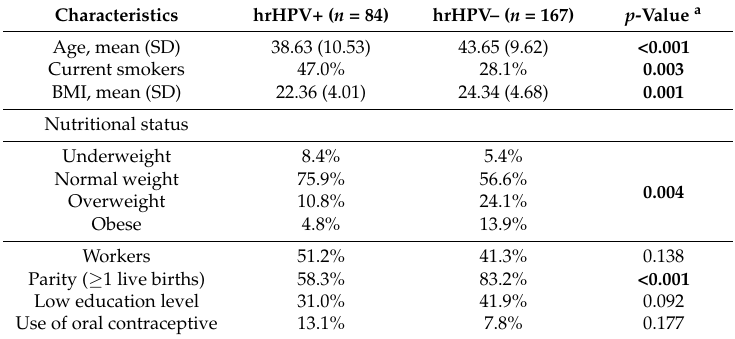
Characteristics of healthy women according to high-risk human papillomavirus (hrHPV) status.